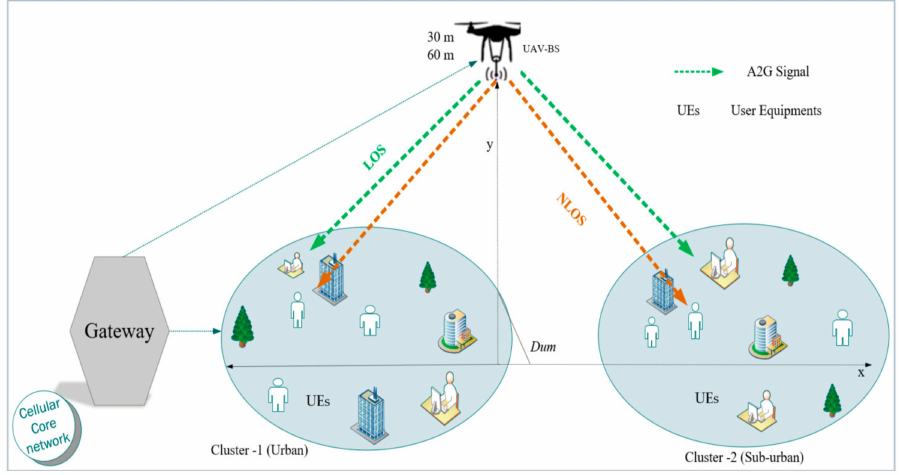
Figure 2. System model: UAV-Bs: unmanned aerial vehicle as base stations; A2G: